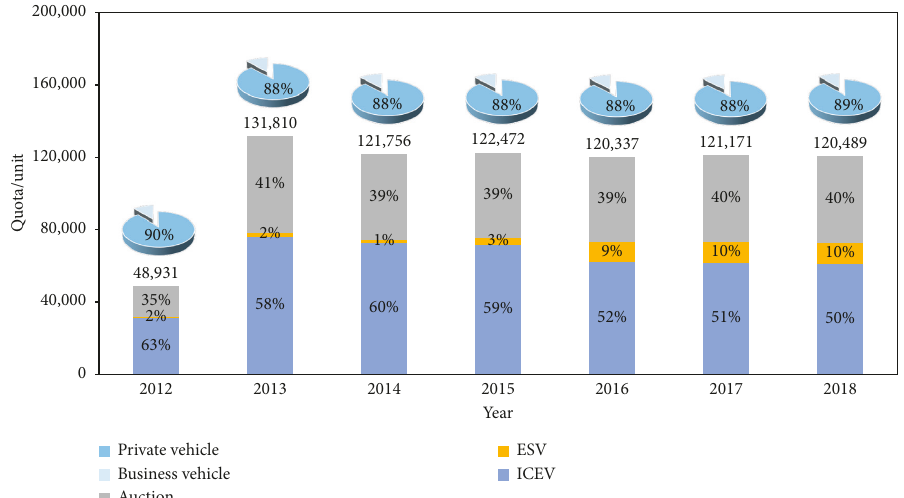
Figure 8: The number of plates issued every year in Guangzhou under purchase restriction policies.